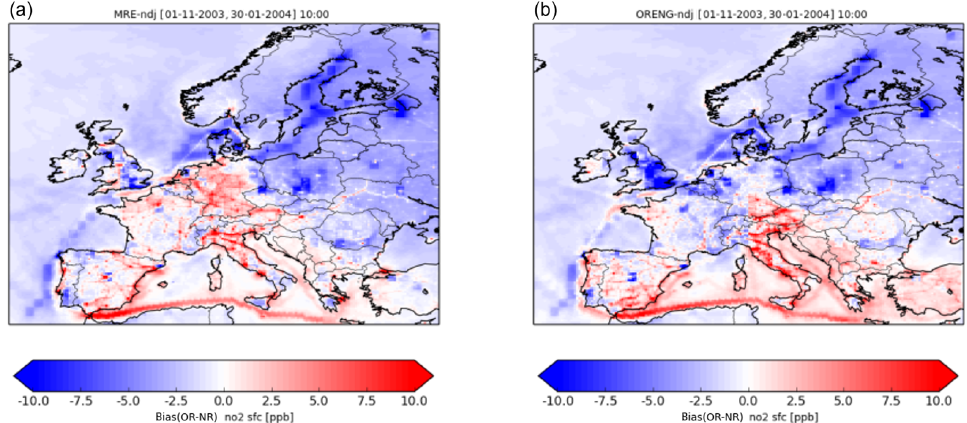
Figure 15. Winter period average surface NO 2 bias at 10:00UTC with respect to the NR (in ppb) for the CR without assimilation (a) and with assimilation of ground-based O 3 + S4 NO 2 (b) .